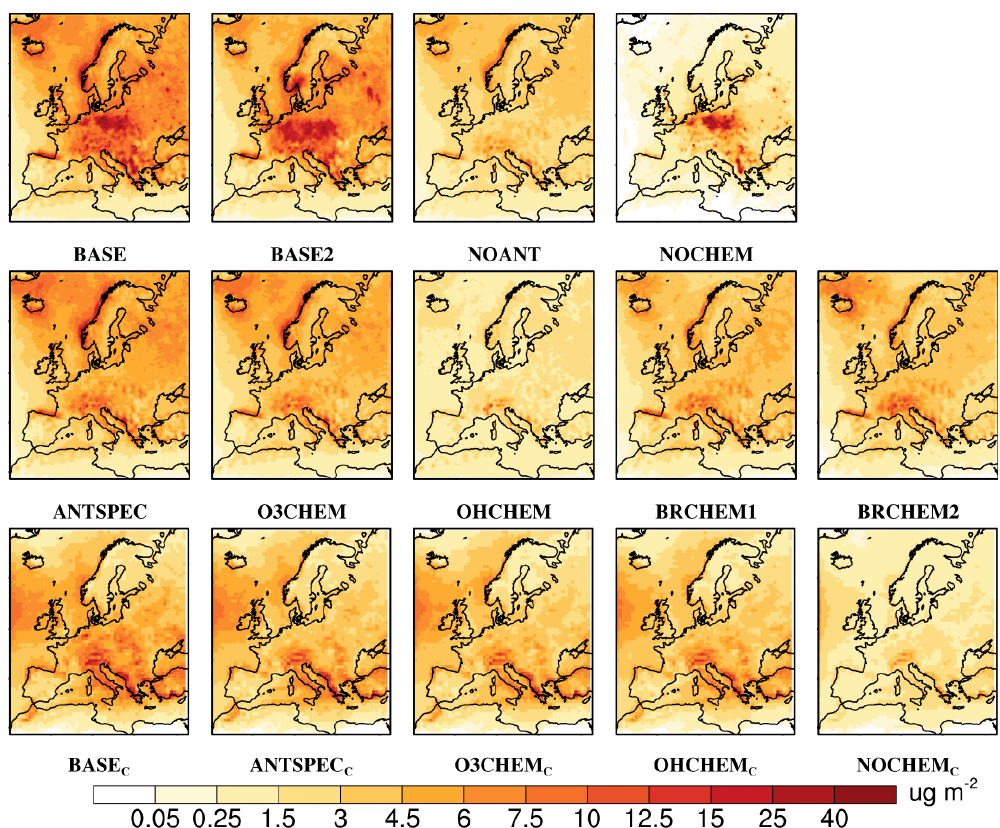
Figure 4. The total Hg wet deposition in the model experiments